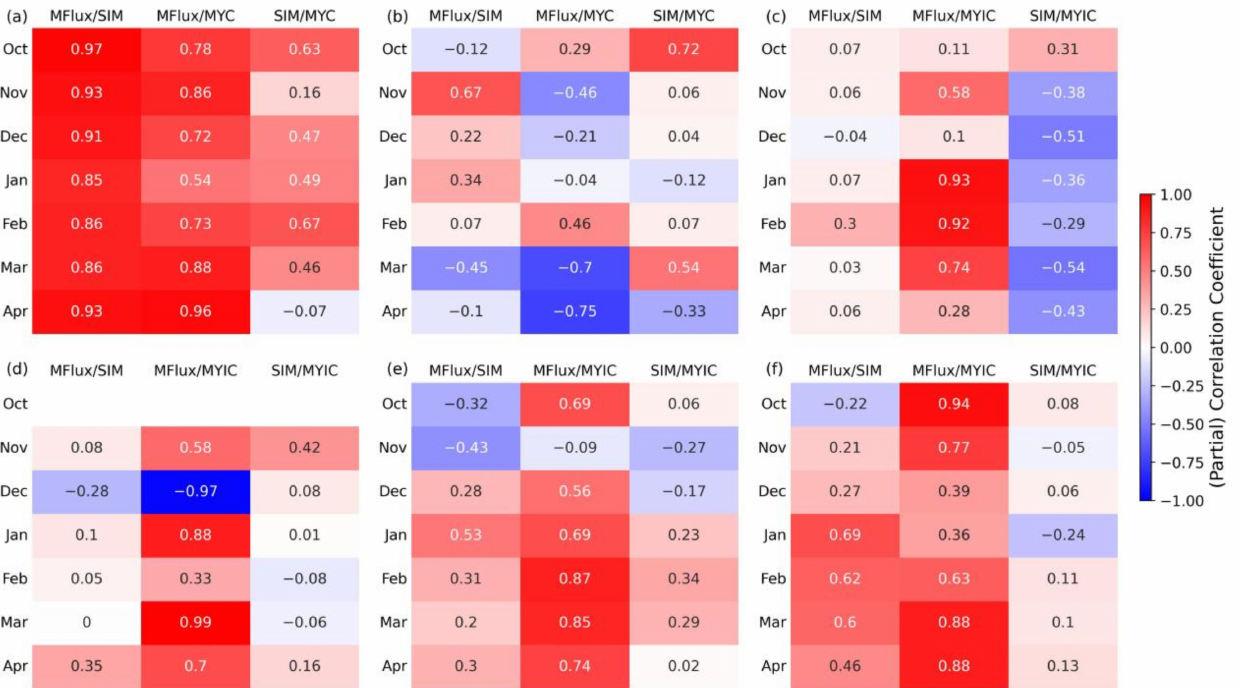
Figure 7. Partial CCs of MYI areal flux (MFlux) with sea ice motion (SIM) and MYI concentration (MYIC) as well as the CC between SIM and MYIC in ( a ) Fram Strait, ( b ) S–FJ, ( c ) FJ–SZ, ( d ) Bering Strait, ( e ) Lanscater Sound and ( f ) North